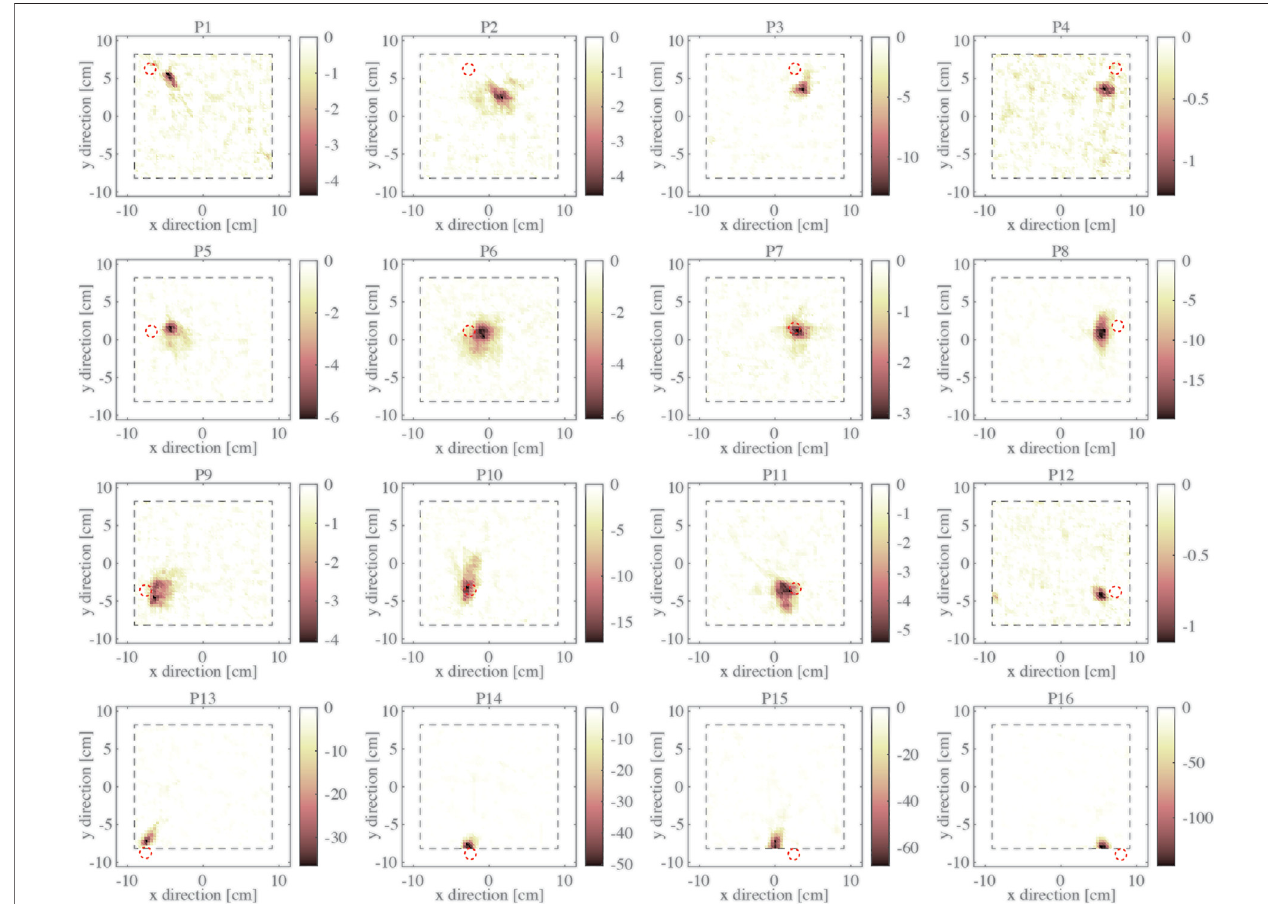
FIGURE 5 | Conductivity distributions obtained using the DNN-based method for Test